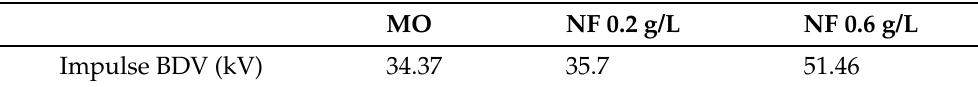
Table 9. BDV obtained for positive lightning impulse for MO and two NFs with different Fe 3 O 4